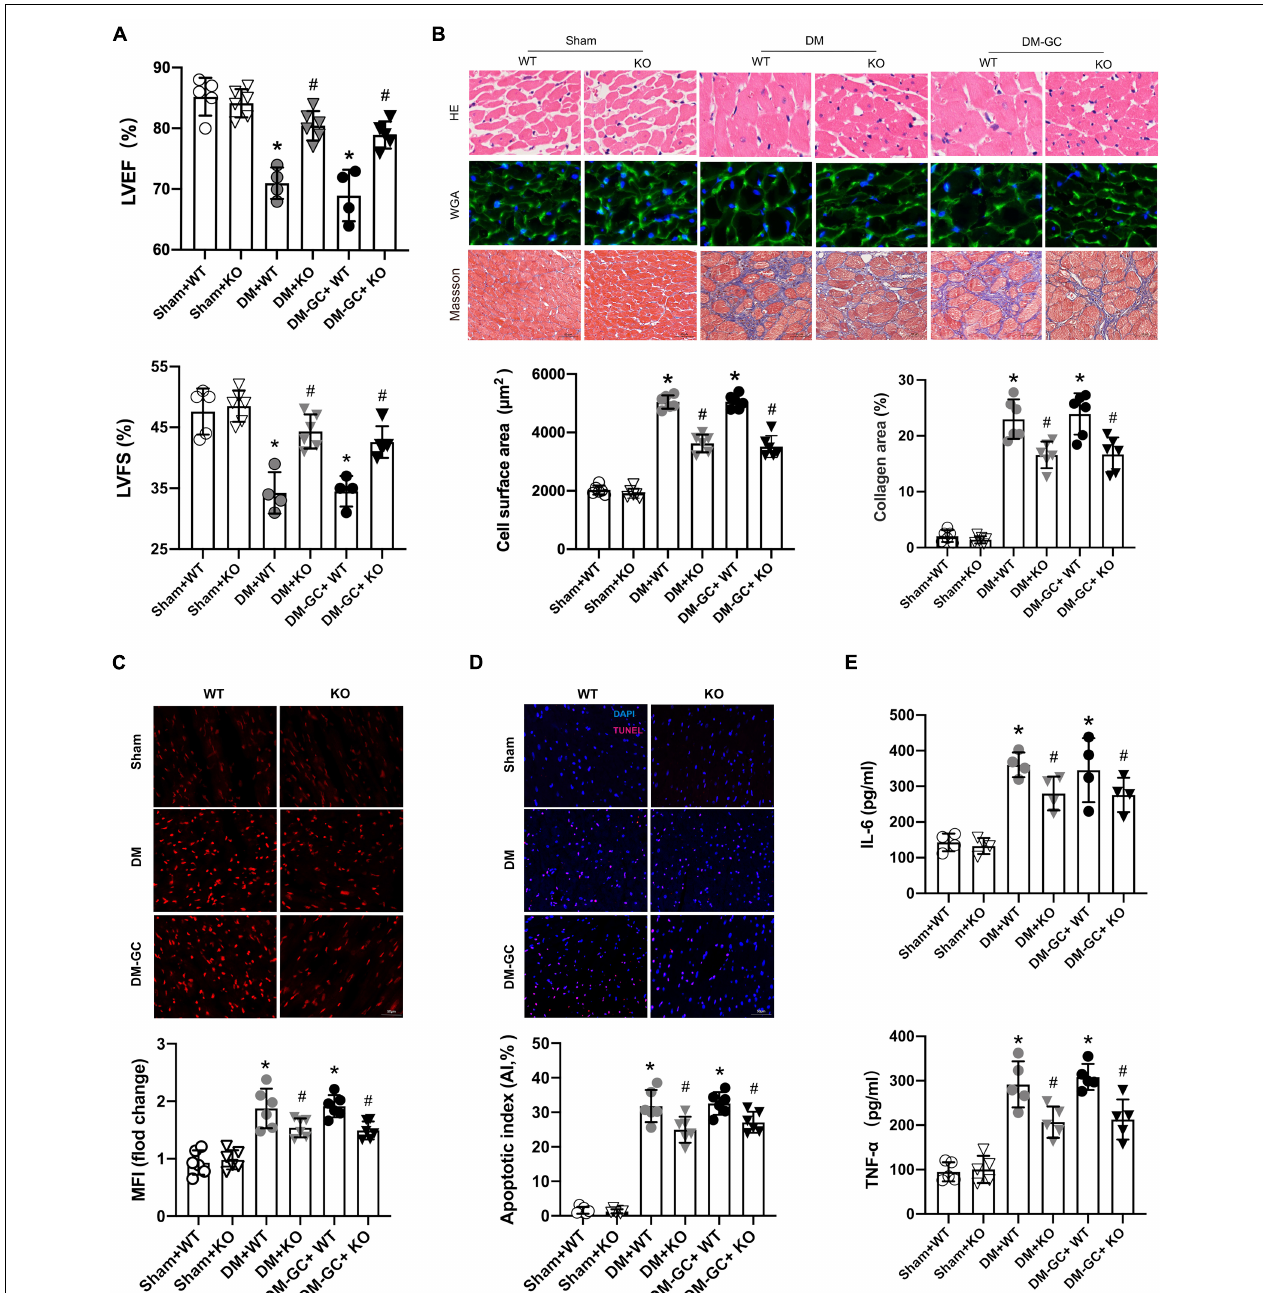
FIGURE 5 | KDM3A knock-out could alleviate hyperglycemia-induced persistent myocardial injury and cardiac dysfunction in vivo . (A) The cardiac function was evaluated by echocardiography including LVEF and LVFS. (B) The degree of myocardial hypertrophy and fibrosis were detected by H&E (X400), WGA (X400), and Masson staining (C, X200). The quantitative analysis was conducted according to the cross-sectional area of myocardial cells and collagen area ( n = 6). Furthermore, the ROS generation (C) , apoptosis in the myocardium (D) were estimated by DHE and TUNEL staining, respectively ( n = 5). (E) The inflammation factors, including IL-6 and TNF- α in myocardium lysis, were measured using ELISA kits ( n = 5). * p < 0.05, as compared to the Sham + WT or the Sham + KO group; # p < 0.05, as compared to the DM + WT or the DM–GC + WT